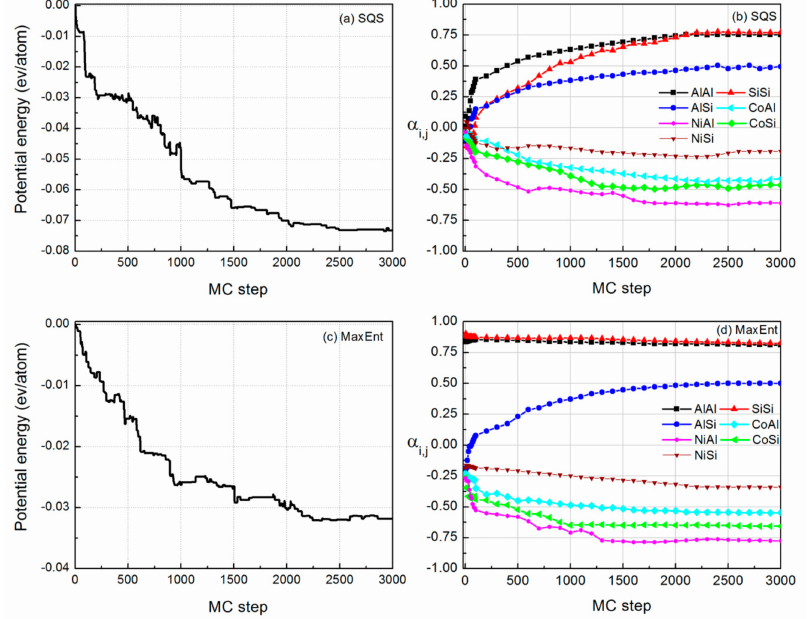
Figure 2. The evolution of relative potential energy and the corresponding short-range order (SRO) parameters of FeCoNi(AlSi) 0.8 alloy: ( a , b ) with special quasi-random structures (SQS) structure; ( c , d ) with maximum entropy(MaxEnt) structure as the initial